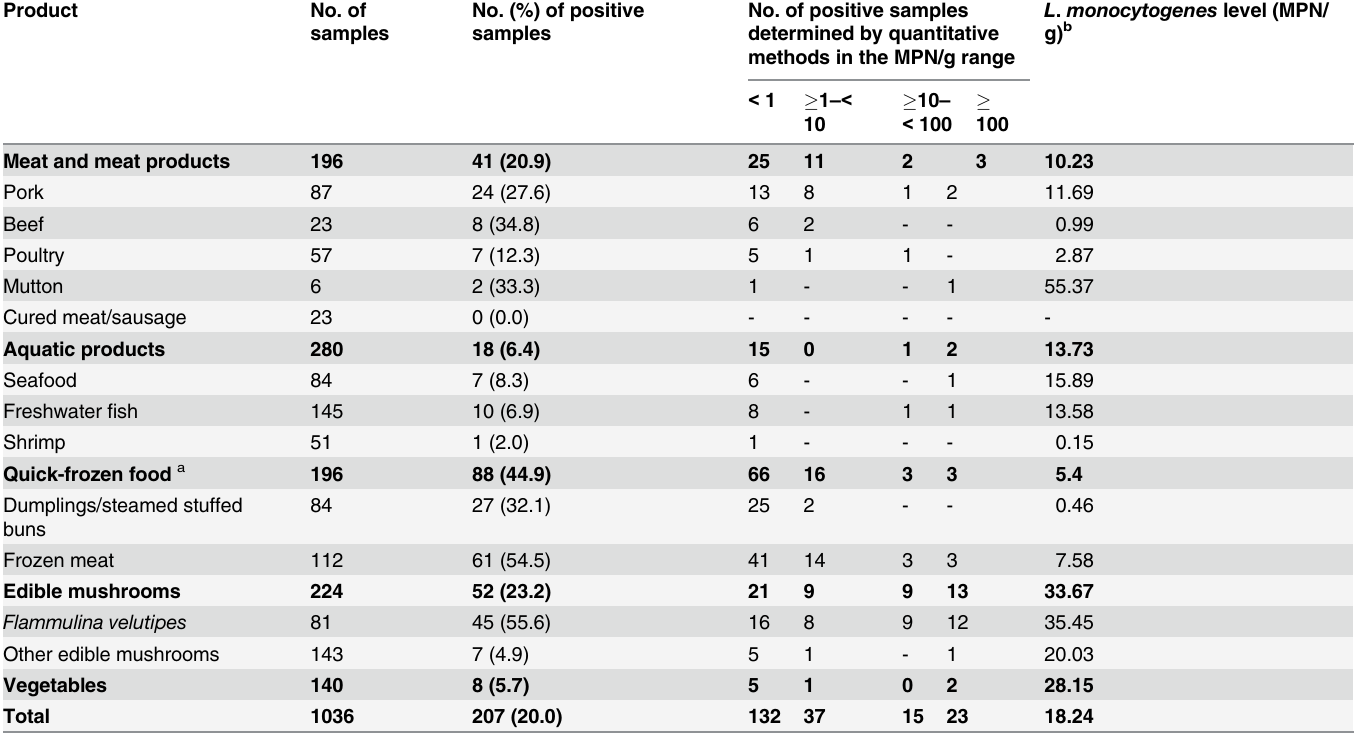
Table 3. Prevalence and level of Listeria monocytogenes in different retail raw foods.